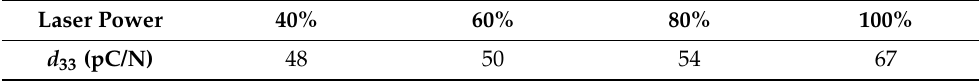
Table 6. Piezoelectric coefficient of PZT laser sintered using 40% to 100% power.